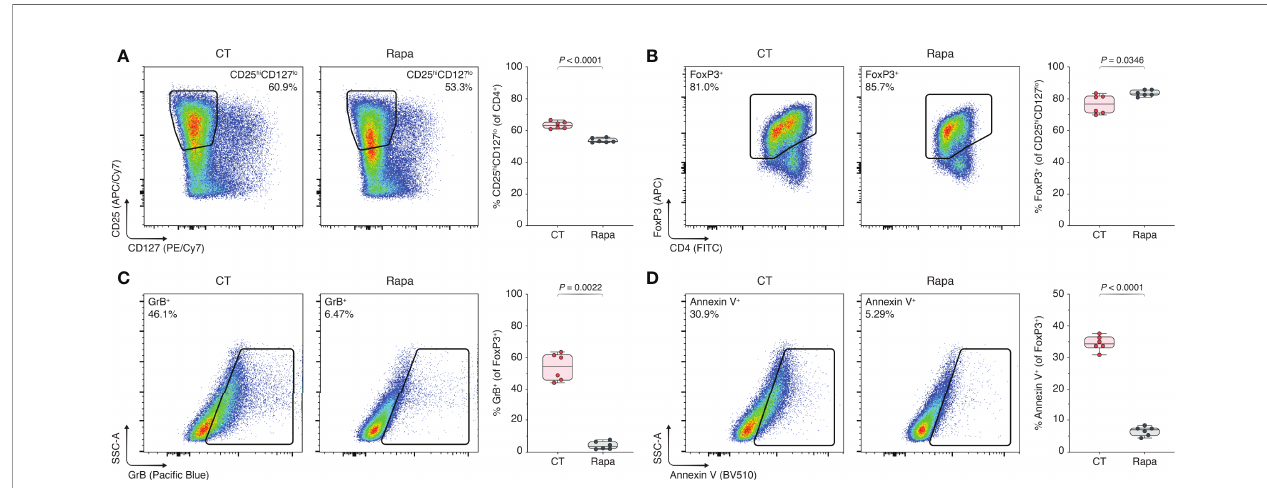
FIGURE 1 | mTORC1 inhibition prevents GrB upregulation and rescues T regs from apoptosis. Human T regs were isolated and expanded for three days with a -CD3, a -CD28, and IL-2, without additional inclusions (CT), or with CT stimulants plus 100 nM rapamycin (Rapa). (A – D) Flow cytometric analyses of CD25 hi CD127 lo subset among CD4 + T cells (A) , FoxP3 + subset among CD25 hi CD127 lo cells (B) , and GrB + (C) and Annexin V + subsets (D) among FoxP3 + T regs , including the respective box plots (n = 3 technical replicates/condition; 2 representative experiments of 5). Data represent boxplots with median, interquartile range, minimum, maximum, and all individual data points of the denoted experimental groups. P values were calculated with independent samples two-tailed Student ’ s t -tests, and non-parametric Mann- Whitney U -tests were performed when the assumption of homoscedasticity could not be met. CT, control; GrB, granzyme B; Rapa,